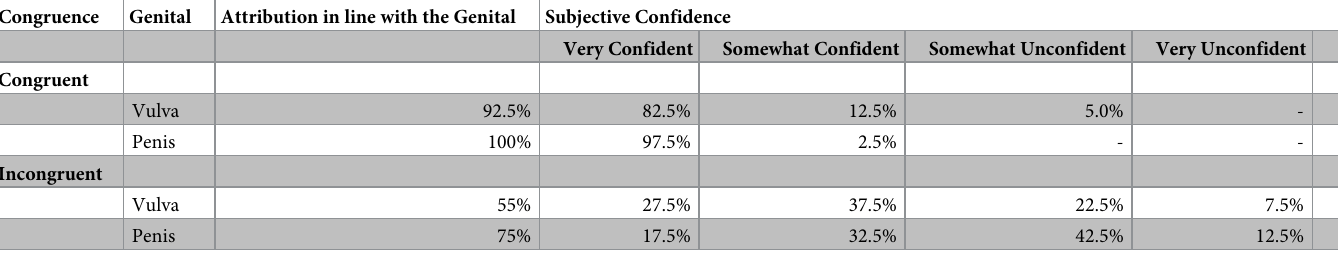
Table 1. Gender attribution in line with the depicted genital and subjective confidence. Congruence